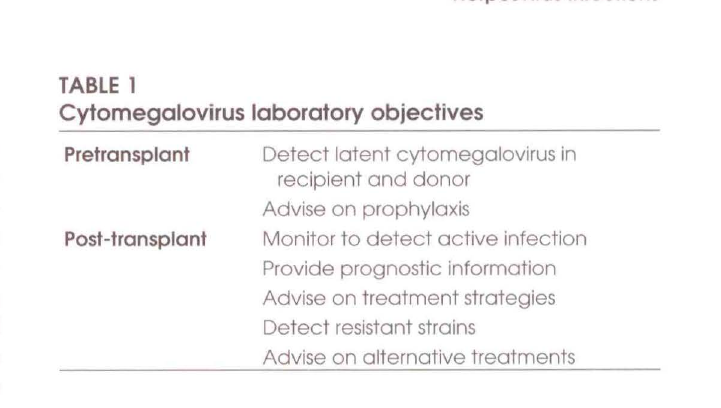
Cytomegalovirus laboratory objectives Pretransplant